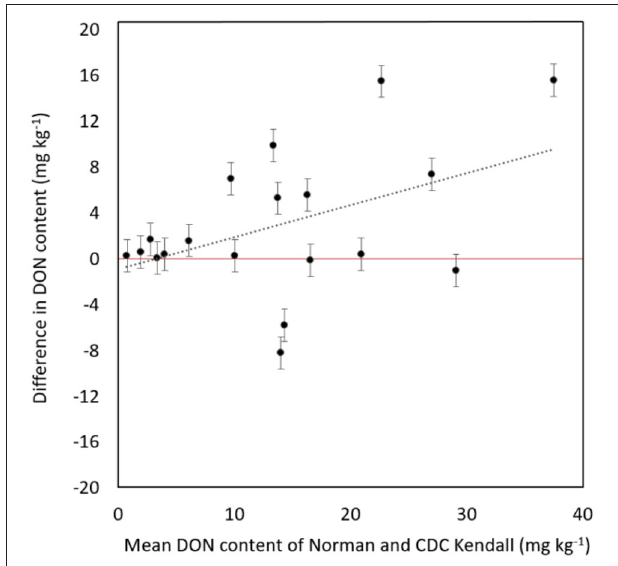
FIGURE 2 | Difference in deoxynivalenol (DON) content (mg kg − 1 ) of moderately resistant “Norman” in head-to-head contrast with “CDC Kendall” over 19 site years tested in an artificially inoculated disease nursery at Brandon, MB, displayed in order of mean DON content of “Norman” and “CDC Kendall.” Error bars represent standard error of